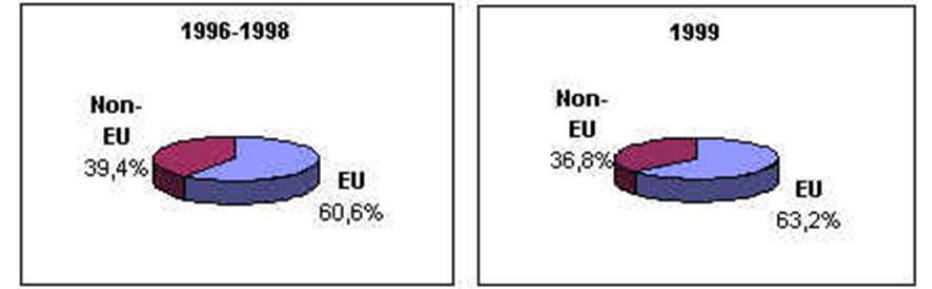
Figure 1: EU and Non-EU